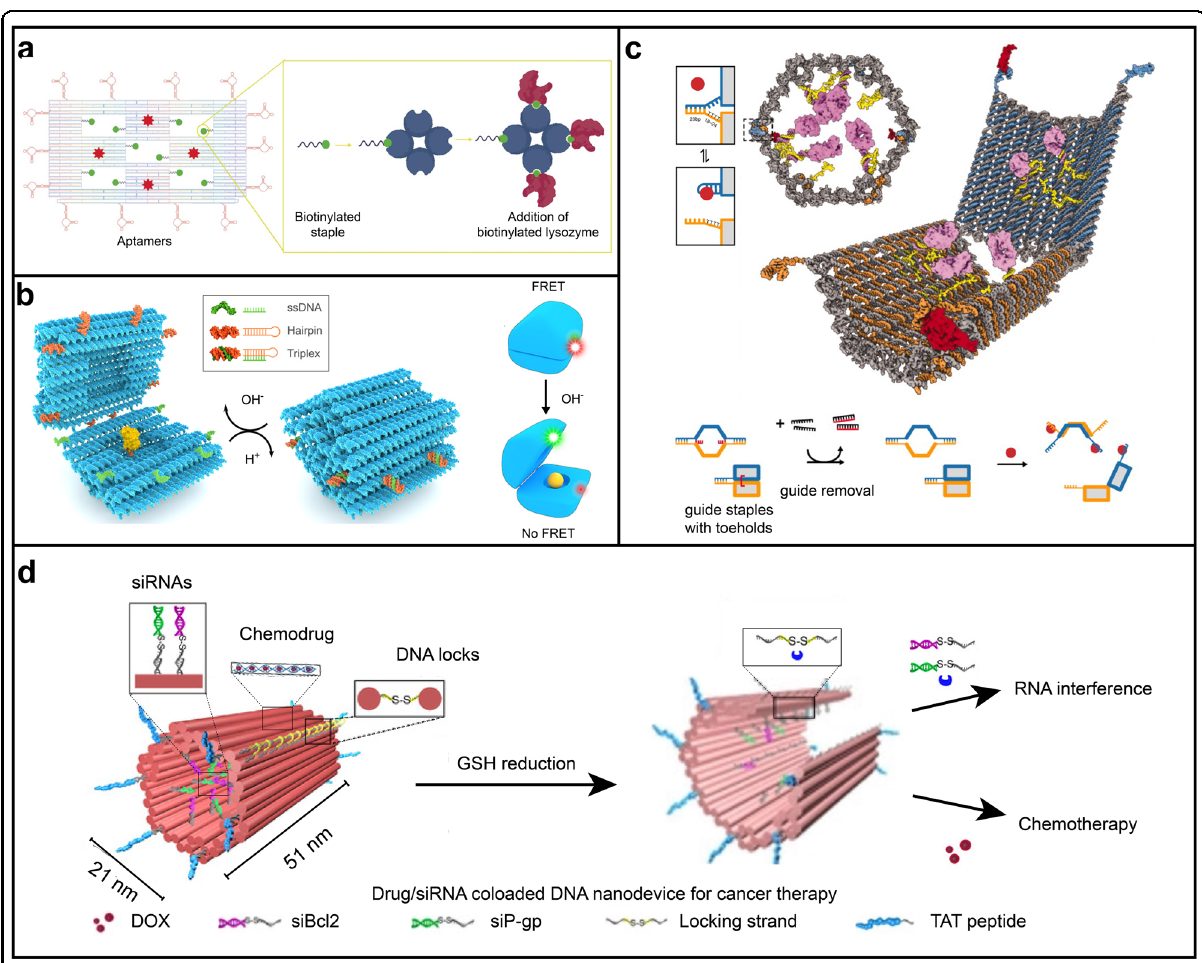
Fig. 6 DNA origami-based smart drug delivery systems. a The E. coli and B. subtilis bacterial strain-targeted aptamer-functionalized DNA origami nanocarriers for antimicrobial delivery. (Reproduced with permission 181 , Copyright 2020, Wiley-VCH). b A recon fi gurable DNA origami nanocapsule for pH-controlled encapsulation and display of cargo molecules. The pH-responsive latches are DNA triplexes that form at low pH and disassemble at high pH. (Reproduced with permission 111 , Copyright 2019, American Chemical Society). c A DNA nanorobot for triggered cargo exposure based on AND logic. The sequestered antibody fragments are exposed for cell signaling regulation when both aptamer-based locks are attached to the targeted cell surface markers. (Reproduced with permission 189 , Copyright 2012, AAAS). d A tubular DNA nanorobot for siRNA/chemo-drug codelivery. TAT peptides are attached to the outer surface of the nanorobot to improve cellular uptake and tumor retention. DNA locks containing disul fi de bonds are used to seal the nanotube and release the siRNA cargos upon interacting with glutathione in the cytoplasm. (Reproduced with permission 193 , Copyright 2021,